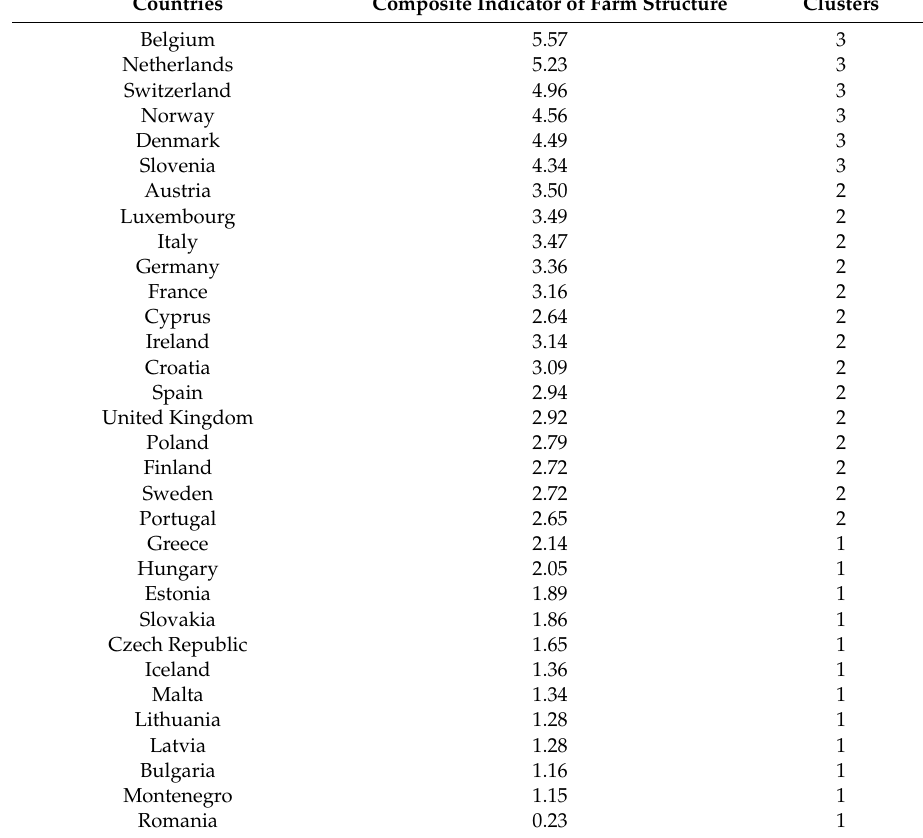
Table A2. The order of European countries through the composite indicator of farm structure; Source: own